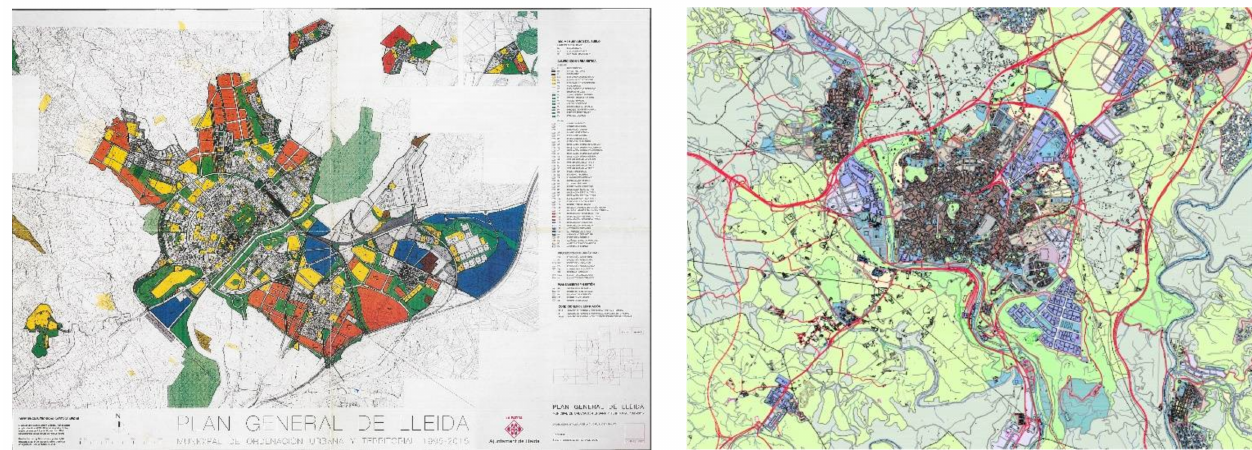
Figure 4. Plan General de Lleida of 1999 ( left ) reprinted with permission from ref. [47] and Plan General de Manresa of 1997 ( right ) reprinted with permission from ref.